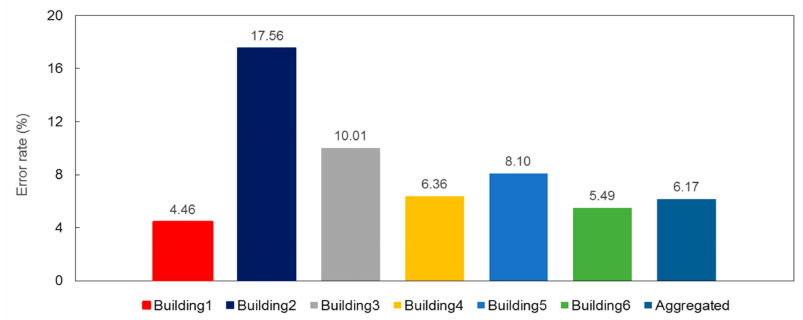
Figure 15. Average percentage error results for summer season.